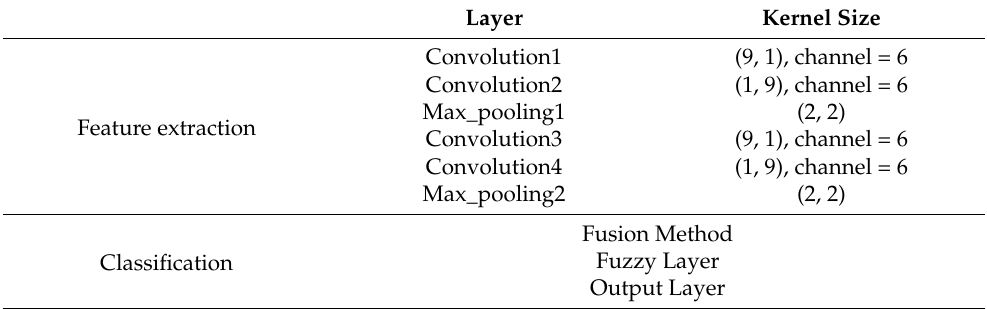
Table 2. The architecture of vector-CFNN.